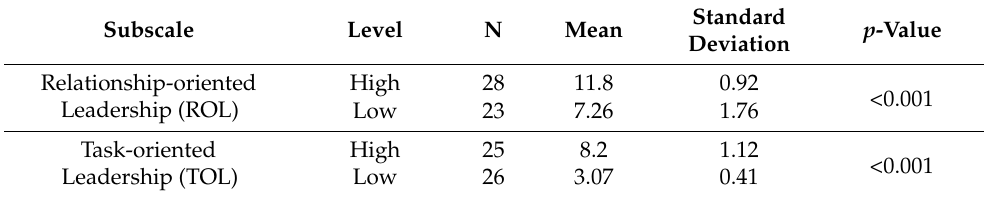
Table 4. Descriptive statistics and statistical analysis of participant ROL and TOL